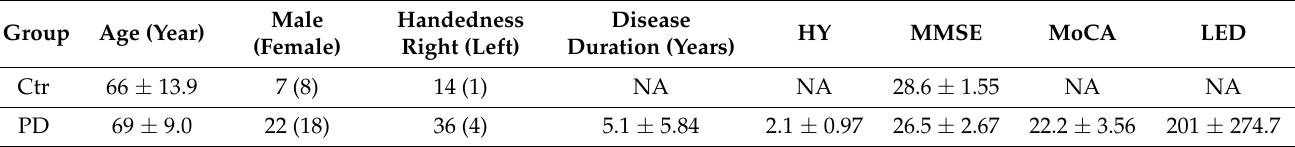
Table 1. Characteristics of the subjects recruited in this